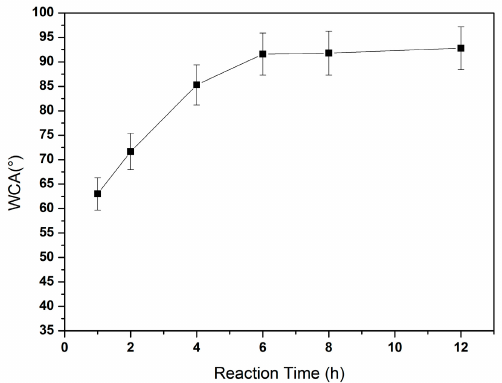
Figure 3. The influence of reaction time for hydrothermal reduction upon WCA values for HRGO-APS